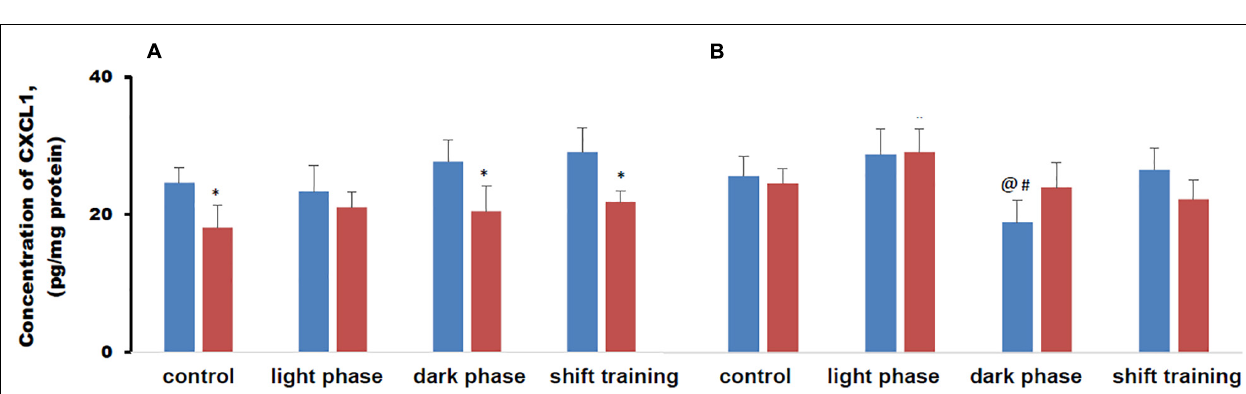
FIGURE 8 | Concentration of chemokine ligand 1 (CXCL1) in mice muscle tissue (pg/mg protein). Panel (A) shows young-age mice. Panel (B) shows old-age mice. Blue columns represent Chow diet and red columns represent high fat diet. Data are presented as the mean ± error of the mean. *Significantly different ( p < 0.05) from Chow diet. #Significantly different ( p < 0.05) from young-age mice. @Significantly different ( p < 0.05) from